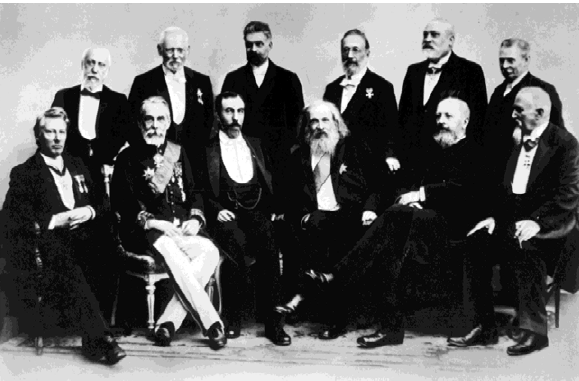
Figure 1. Beilstein with the group of the prominent chemists (Pub- lic domain, from reference